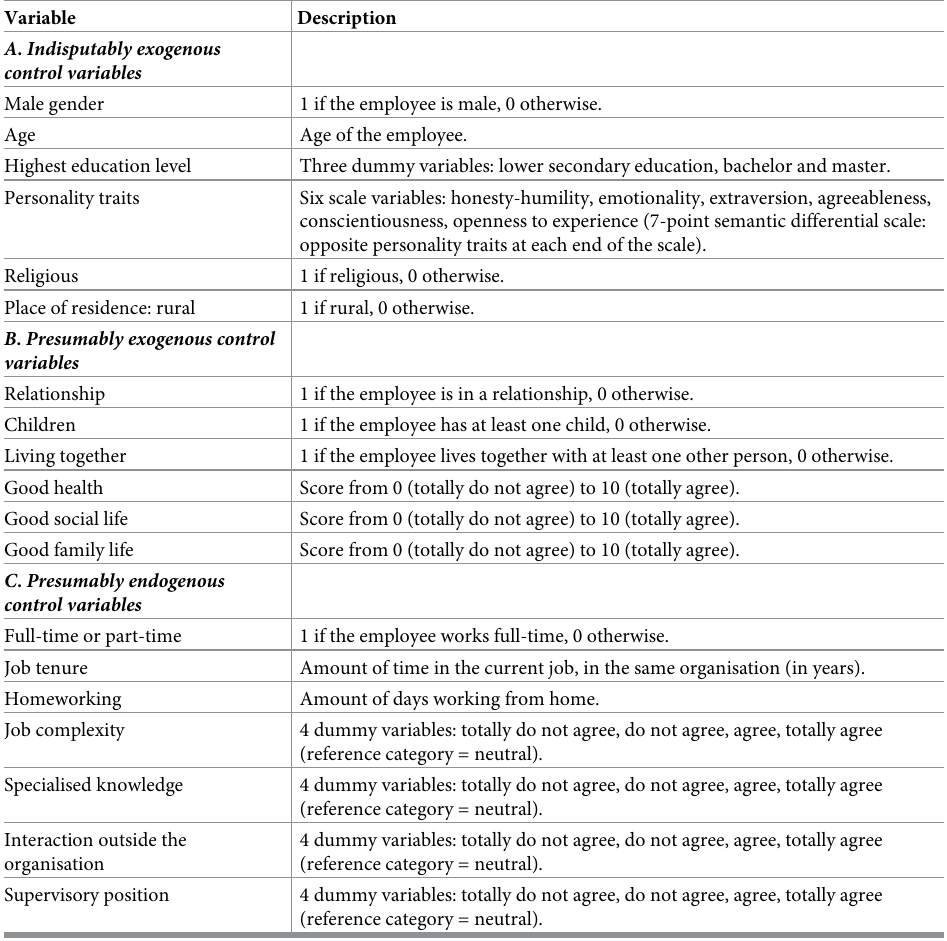
Table 1. Variable specification of the control